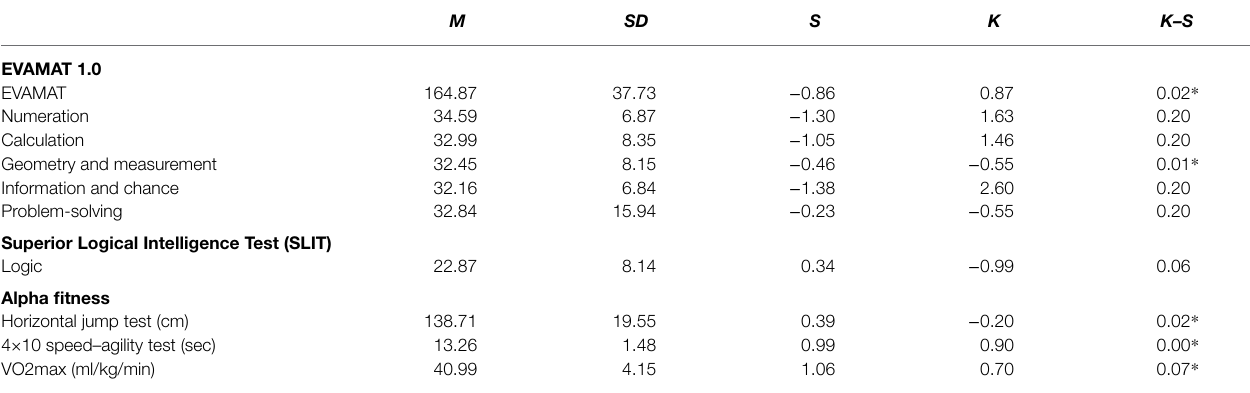
TABLE 1 | Descriptive measures, skewness, kurtosis, and Kolmogorov–Smirnov test for study variables. M SD S K K–S